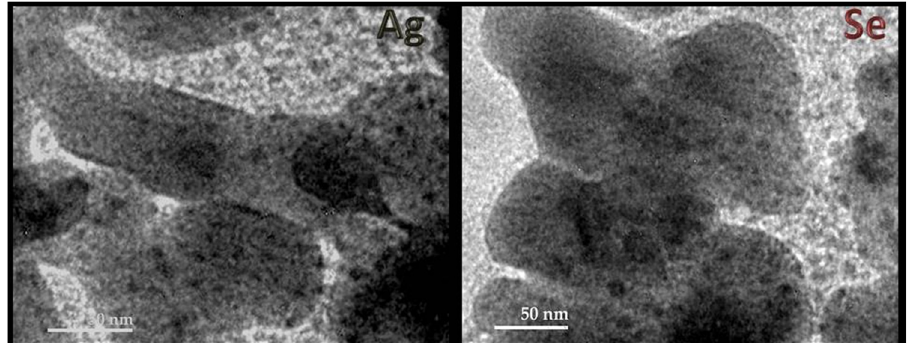
Figure 3: TEM imaging of Fu - synthesized Ag - NPs and Se -